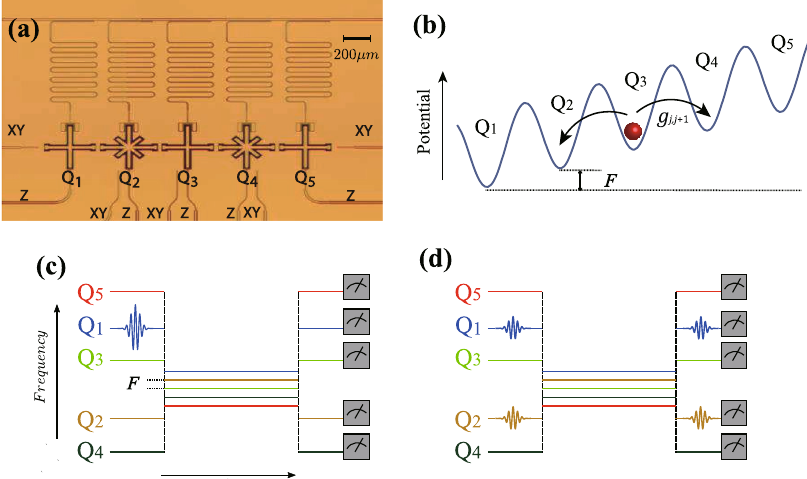
Fig. 1 Experimental setup. a Circuit diagram of the device. There are 5 superconducting transmon qubits ( Q 1 − Q 5 ) arranged into a chain 47 – 52 . The nearest-neighbor two qubits are coupled capacitively, and the negative anharmonicity U of each qubit gives the on-site attractive interaction. The frequency of each qubit is tunable by individual microwave driving through the fl ux-bias line (Z line). The qubit fl ipping can be realized by XY lines. Each qubit is coupled to a resonator for individual and simultaneous readout. More experimental details of the system are presented in the Supplementary Note 1. b The sketch of the corresponding Bose-Hubbard chain with a linear potential. The detuning of the nearest-neighbor two qubits is the potential gradient F . The red ball represents the photon (the excitation of the qubit), which can tunnel to the nearest-neighbor sites (black arrows). c Pulse sequences for studying the transport of spin. The qubits are ordered by their frequencies, and initialized at their idle frequencies and the state 0 j i , see Supplementary Note 1. A. Then, we excite Q 1 to the state 1 j i by a X gate and bias all qubits at the work point with square waves. After the system evolves for a speci fi c time t , all qubits are biased back to their idle frequencies, and we fi nally read out each qubit. d Pulse sequences for studying the thermal transport. We use two X /2 gates at Q 1 and Q 2 two prepare the initial state X þ X þ 000 j i , and other sequences is the same as c